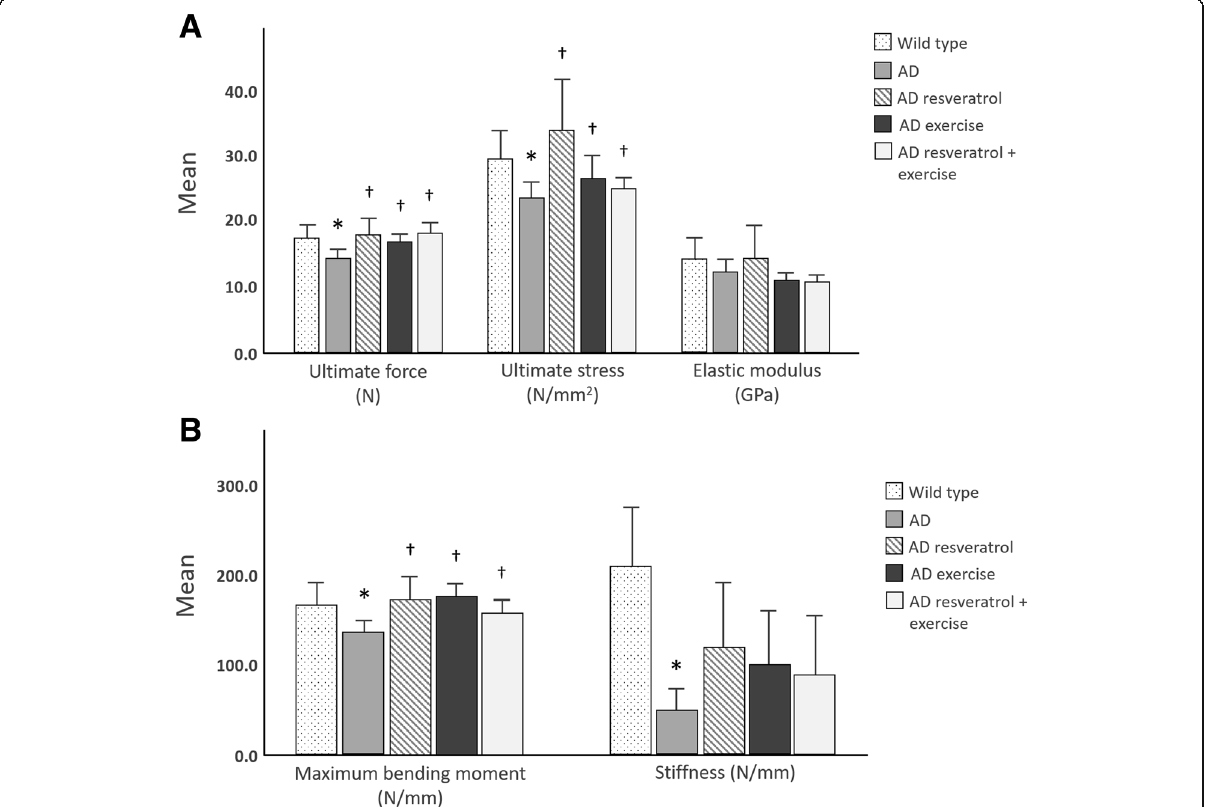
Fig. 1 Results of three-point bending testing. a Tibias of AD control mice require less force and stress to fracture than wild type mice (* P <0.05). Treatment with resveratrol and exercise increase ultimate force and ultimate stress ( † P <0.05), but not elastic modulus ( P >0.05) in comparison to AD controls. b Maximum bending moment was lowest in AD controls (* P <0.05) and was reversed by resveratrol and exercise treatment ( † P <0.05). Tibias of AD control mice are less stiff than wild type mice * P <0.05), but treatment did not affect tibial stiffness ( † P >0.05). Error bars are